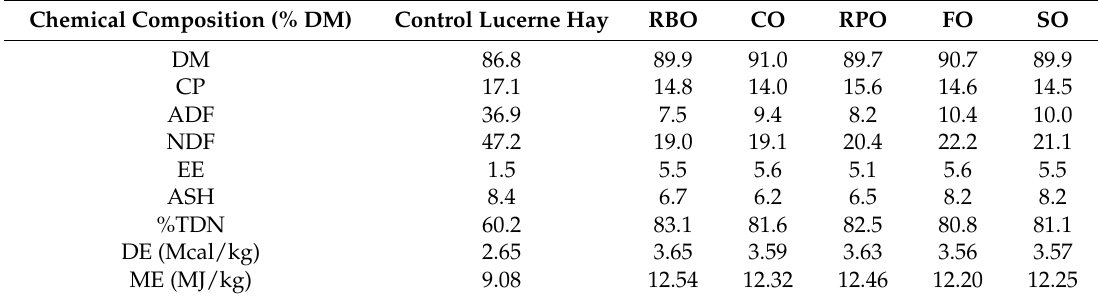
Table 1. Proximate analysis of the experimental and basal